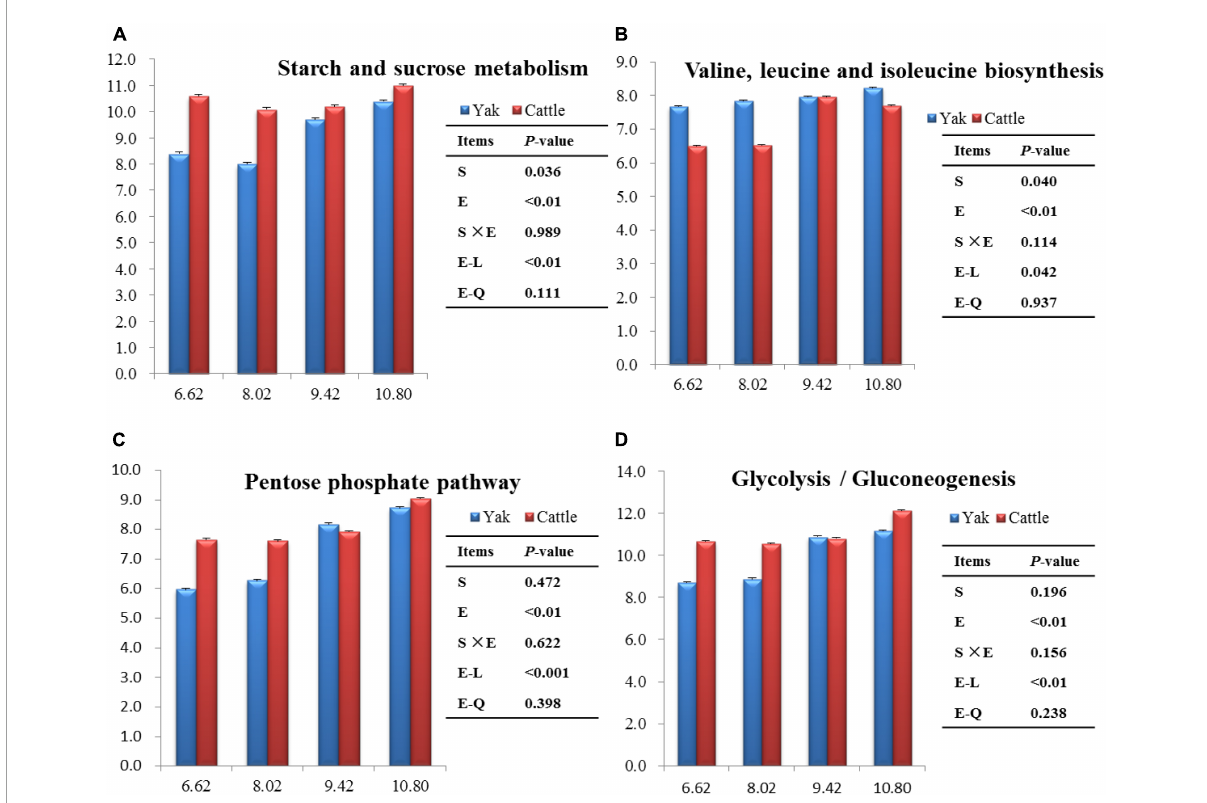
FIGURE8 Significant differences of the functional pathways between species and among dietary energy levels (MJ ME/kg